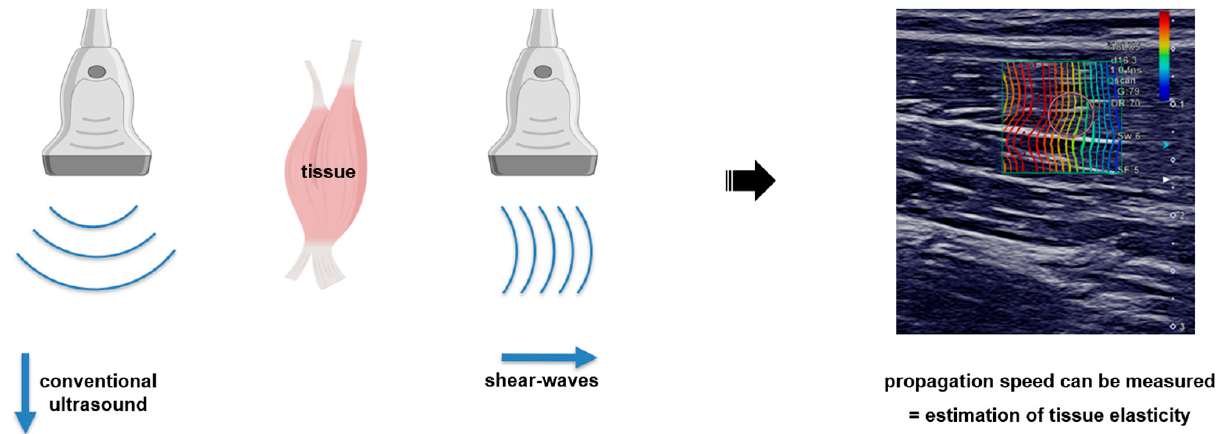
Figure 1. Visual description of muscle shear wave elastography (SWE). A conventional ultrasound propagates comparatively fast longitudinally through the tissue and provides a high image resolution ( left ), while a SW moves slowly transversely through the tissue and provides information about tissue elasticity in meters per second ( center ). On the right , is a screenshot of a Canon Aplio i800 system during sonography of the biceps brachii.